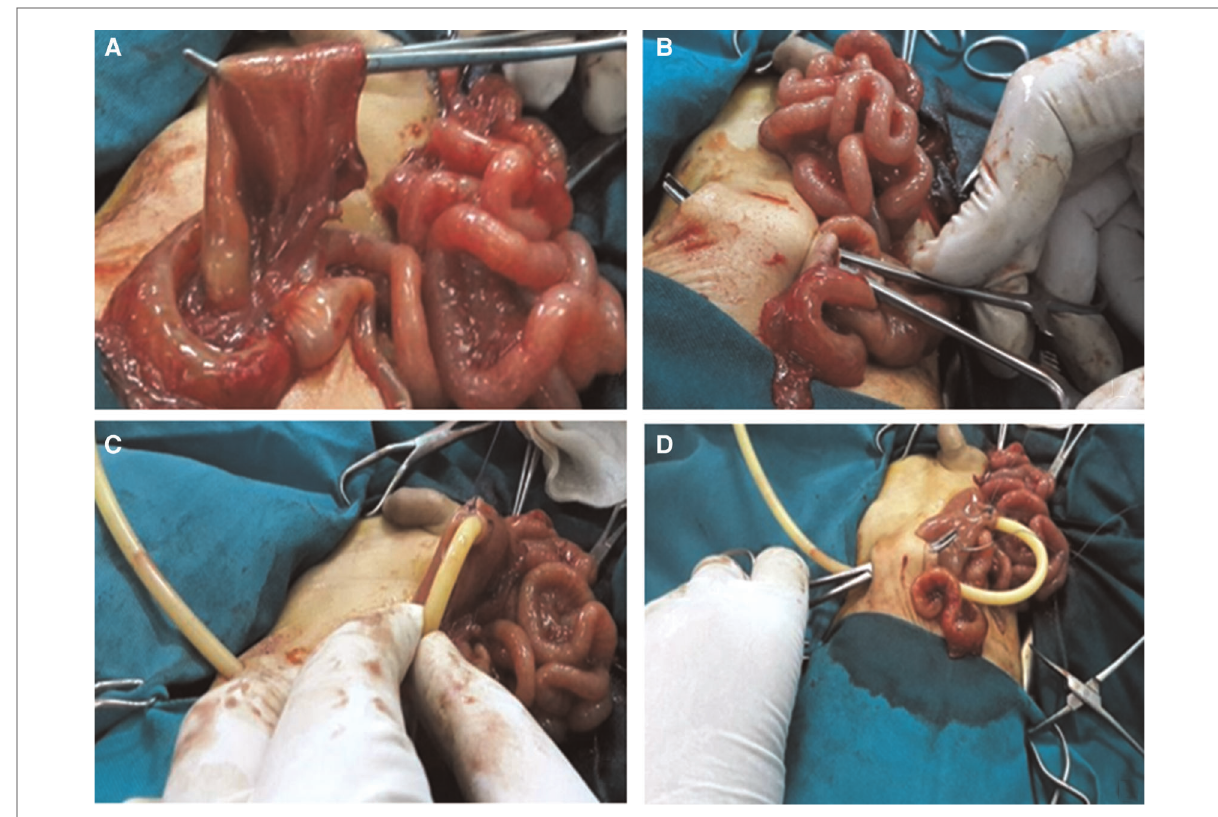
FIGURE 1 ( A ) Enterotomy performed through the proximal dilated jejunum. ( B ) Incision through the anterior abdominal wall to provide route for T-tube. ( C ) T- tube secured in place by purse-string sutures. ( D ) T-tube exteriorized through the abdominal wall fi xing the enterostomy and ensuring the proximal dilated jejunum against the anterior abdominal